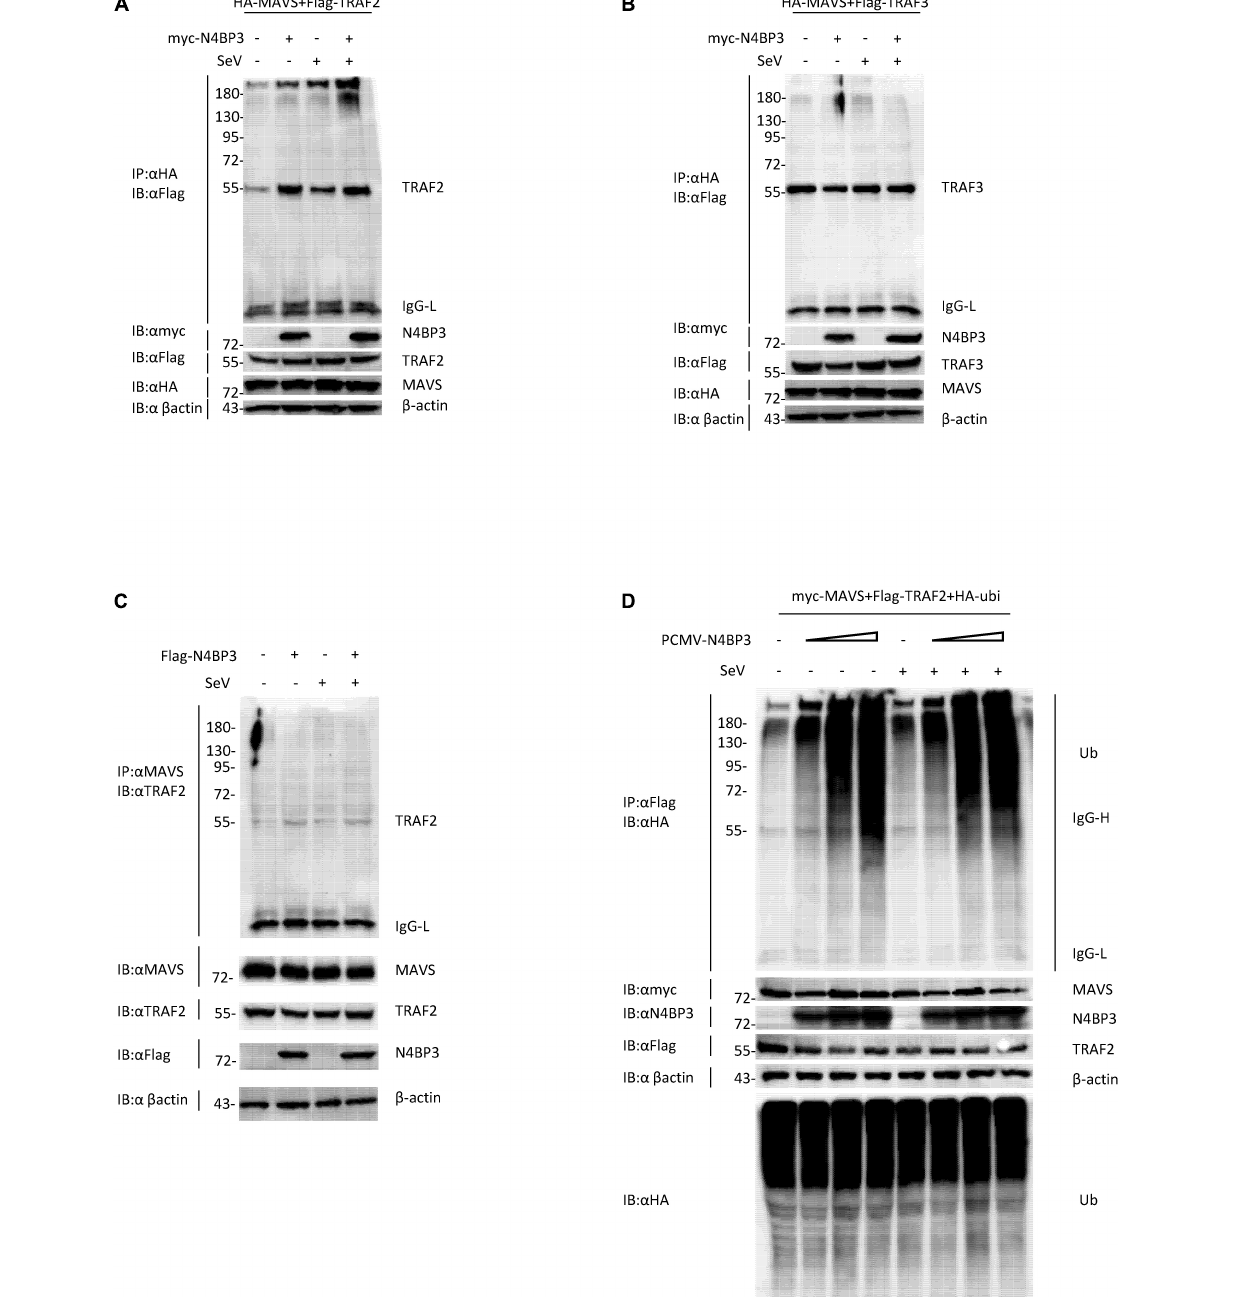
Frontiers in Microbiology |